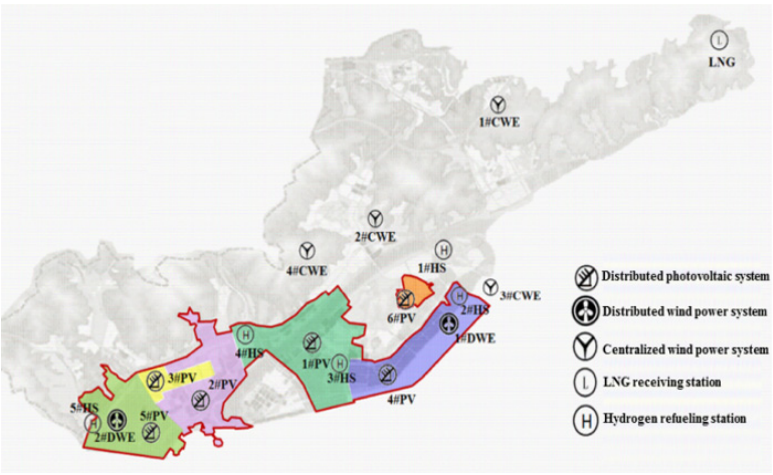
Figure 9. Source-side energy plan layout.